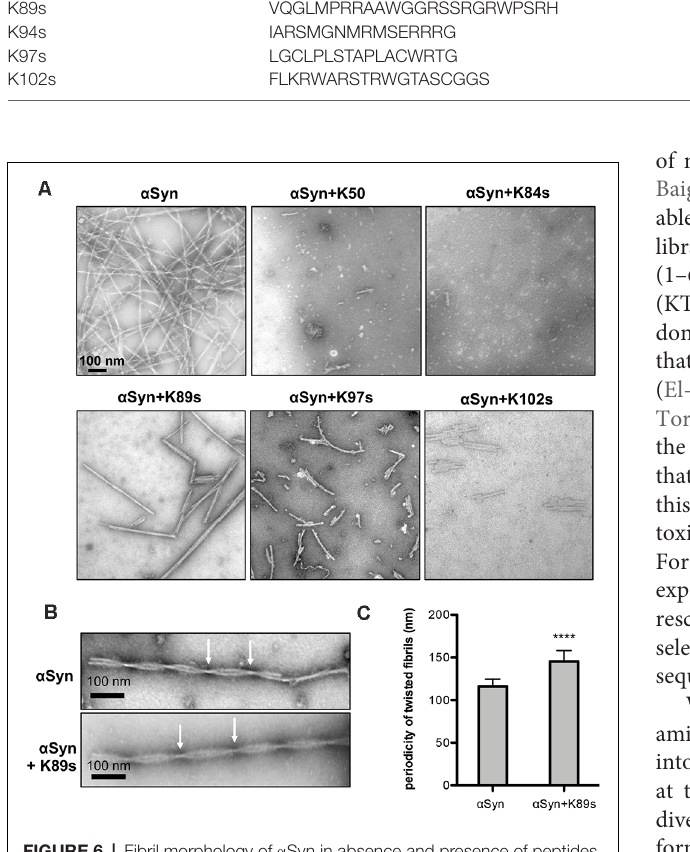
FIGURE 6 | Fibril morphology of α Syn in absence and presence of peptides. (A) Representative transmission electron microscopy (TEM) images showing endpoint samples of in vitro formed α Syn fibrils after 100 h. (B) Periodicity of the fibrils, formed by control α Syn sample and in presence of K89s. Arrows mark crossovers of two twisting protofibrils. (C) Quantification of the mean fibril periodicity of α Syn in the absence and presence of K89s. The significance of differences was calculated with a t -test (**** p < 0.0001; n =